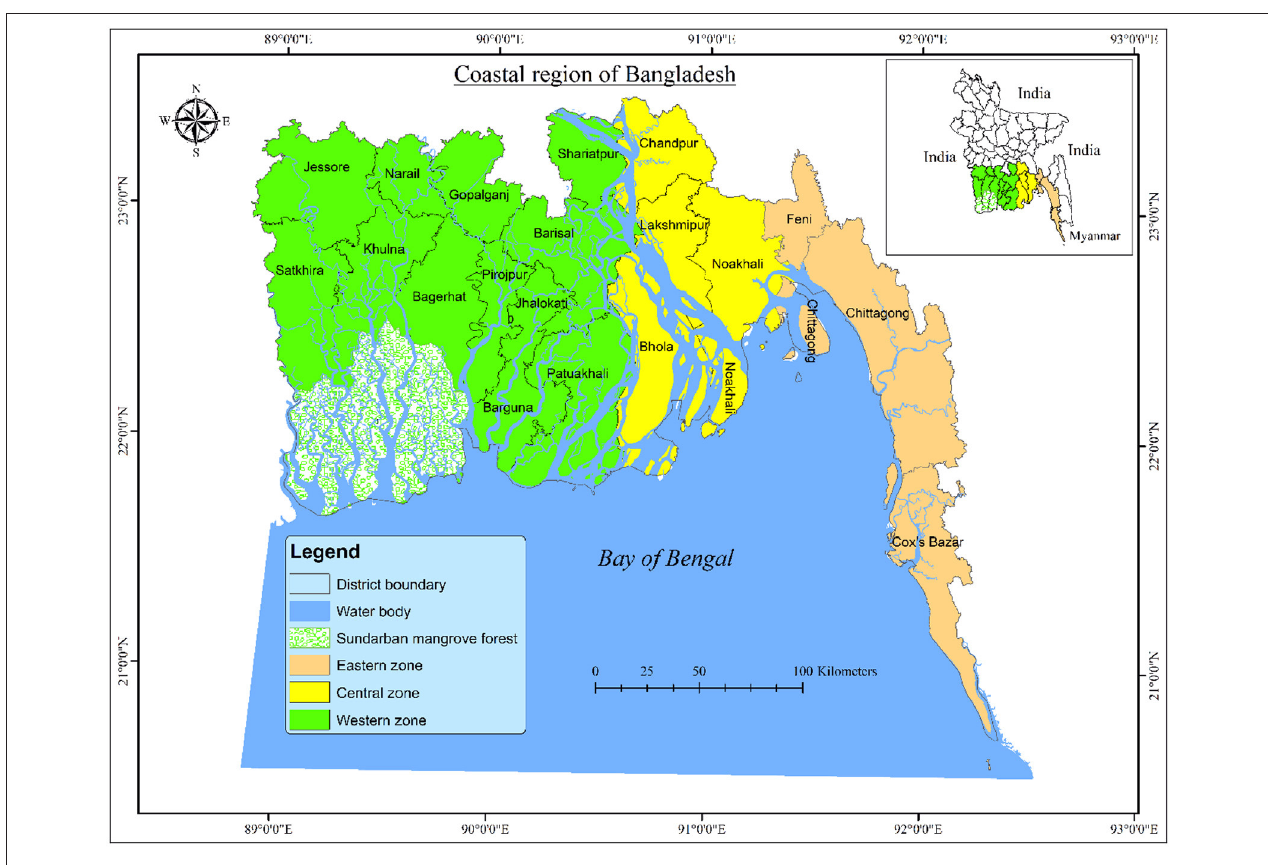
FIGURE 2 | Map of coastal region of Bangaldesh. Source: adapted from Hoque et al. (2019).